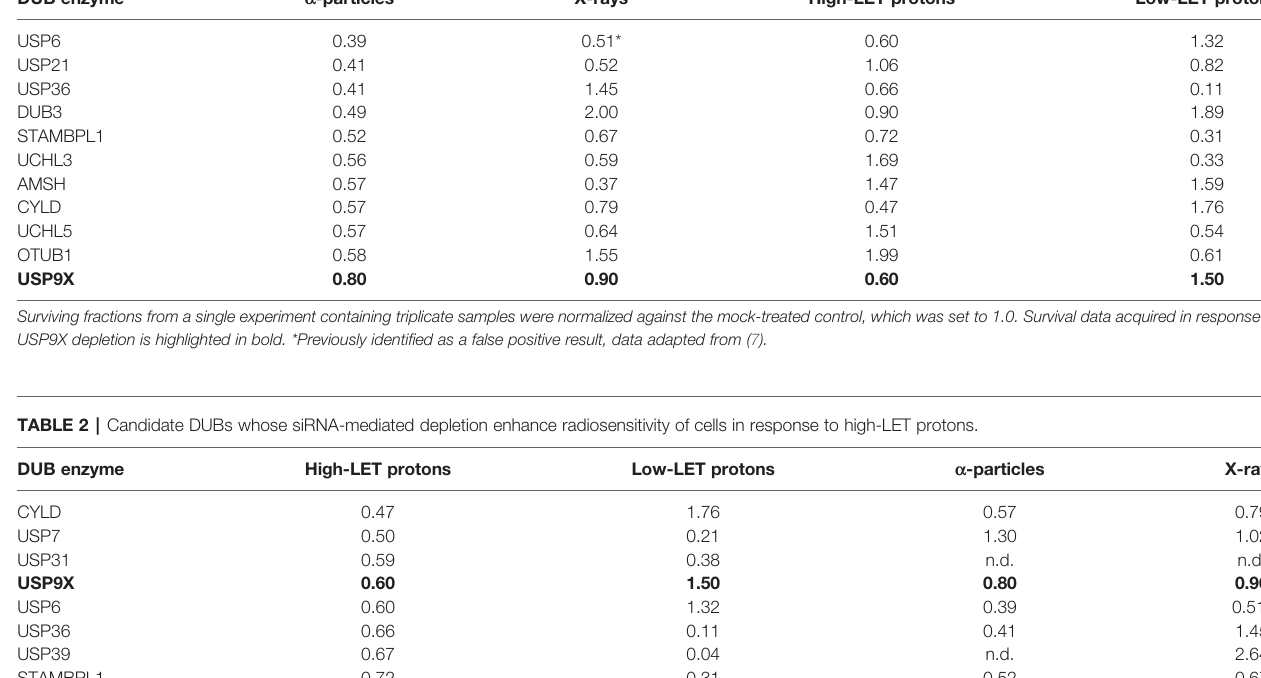
TABLE 1 | Candidate DUBs whose siRNA-mediated depletion enhance radiosensitivity of cells in response to a -particle radiation. DUB